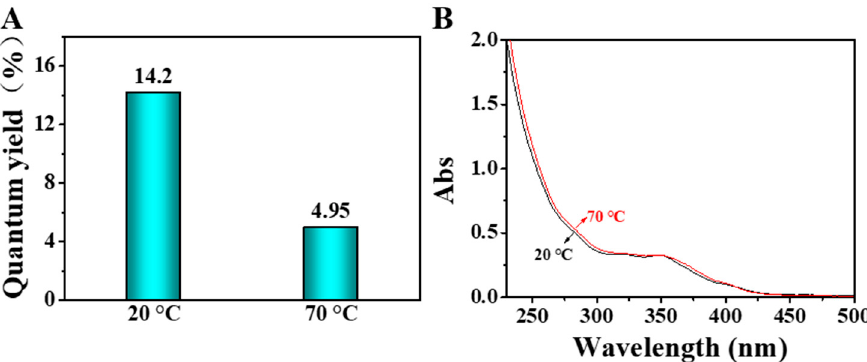
Figure 5. Quantum yields ( A ) and UV-visible absorption spectra ( B ) of DE-Au NCs at 20 and 70 °C, respectively.